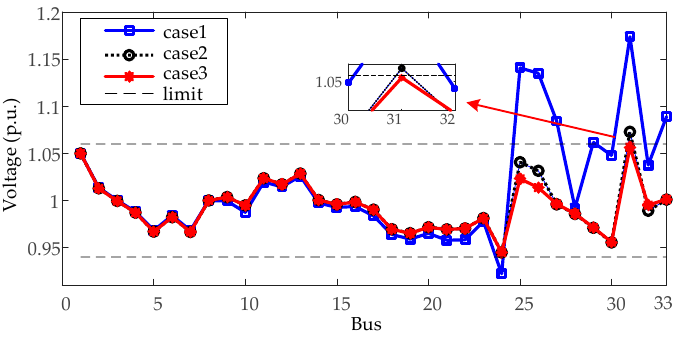
Figure 4. Bus voltages of the regional power grid.